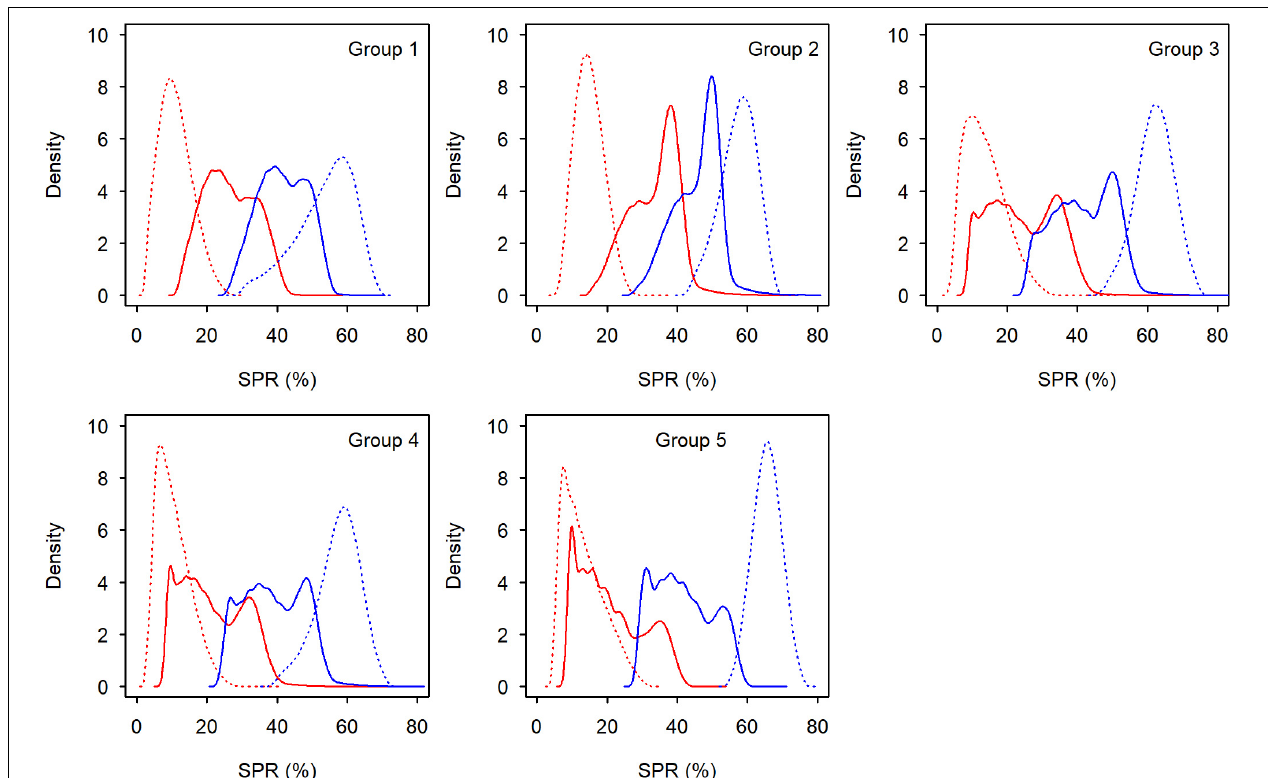
FIGURE 8 | Distribution of spawning potential ratio at F cur (red lines) and at F MSY (blue lines) for each group of small yellow croakers when L c = 12.0 cm ( t max = 3 years: solid lines; t max = t optmax : dotted